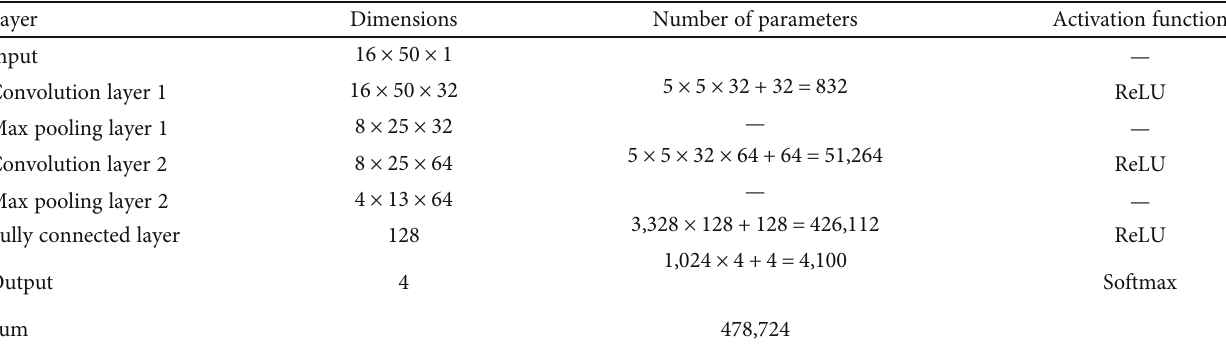
Table 5: Neural network structure and the number of parameters in the